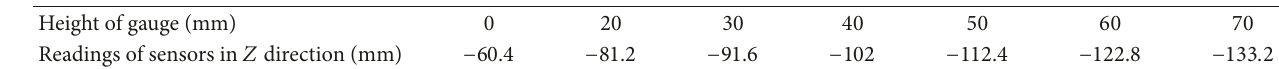
Table 6: Readings of sensors in 𝑍 direction.